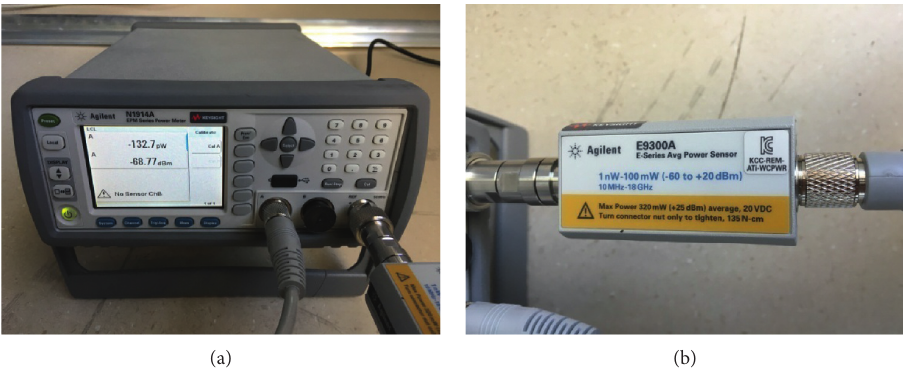
Figure 9: Agilent power meter and power